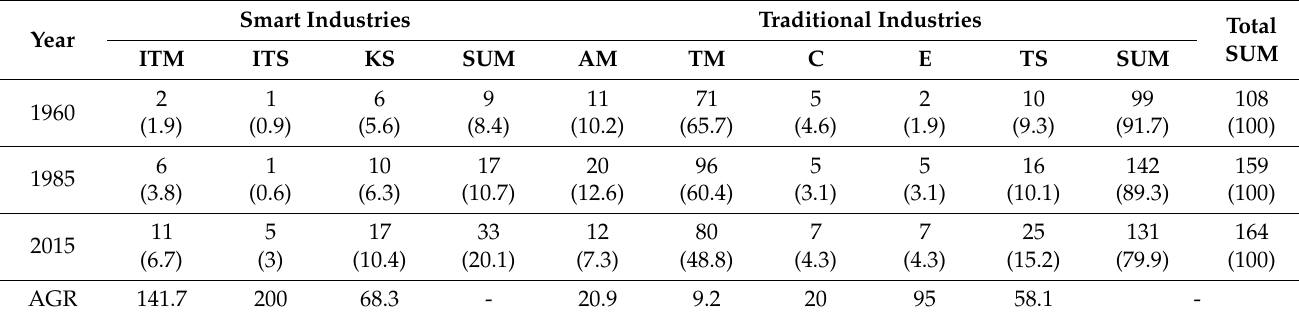
Table 1. Changes in the smart spectrum (unit: no,